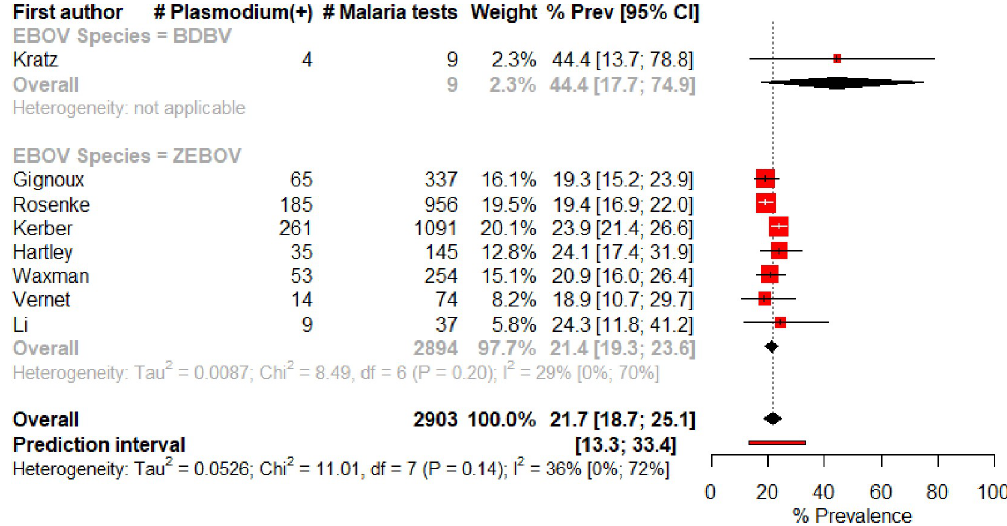
Fig 2. Meta-analysis of the prevalence of Plasmodium infection among EVD(+) cases, overall and split by species of Ebolavirus.